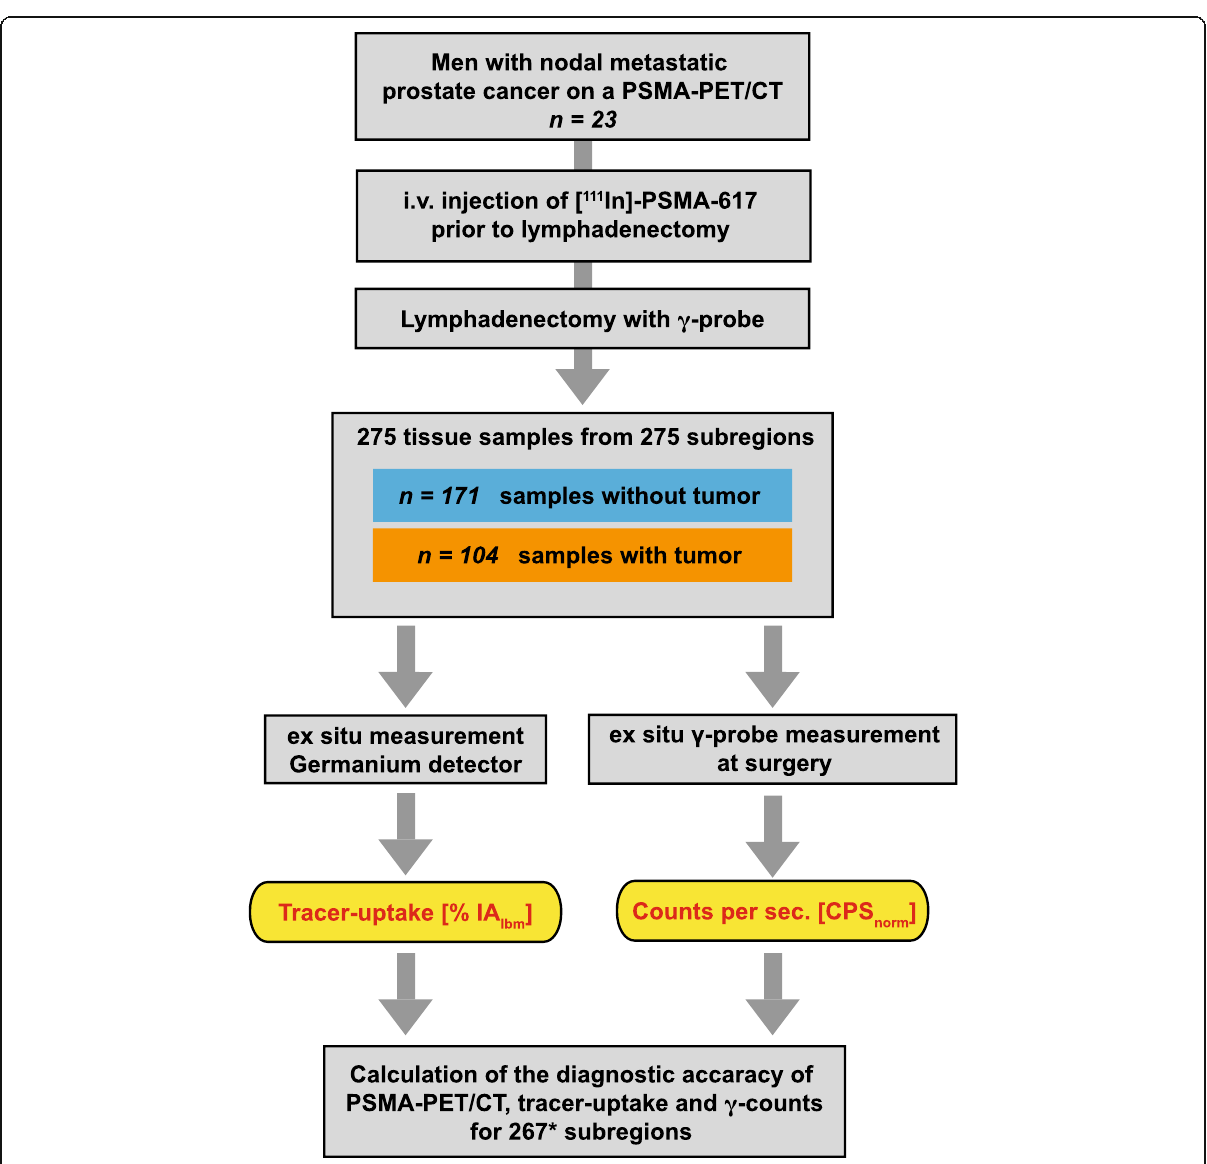
Fig. 2 Workflow and tissue sample processing from 23 lymphadenectomies after surgery with [ 111 In]PSMA-617. Resected tissue specimens (consisting out of LN, LNM and fibrofatty tissue) from a total of 275 subregions were analysed with a γ -probe at surgery followed by histopathological analysis. Tracer uptake in tissue samples was analysed with a germanium detector. The asterisk symbol indicates that 8 of 275 subregions were excluded from the analysis because a follow-up PSMA-PET/CT showed the persistence or progression of the PET-positive lesion(s) indicating that the LN(s) had not been removed during